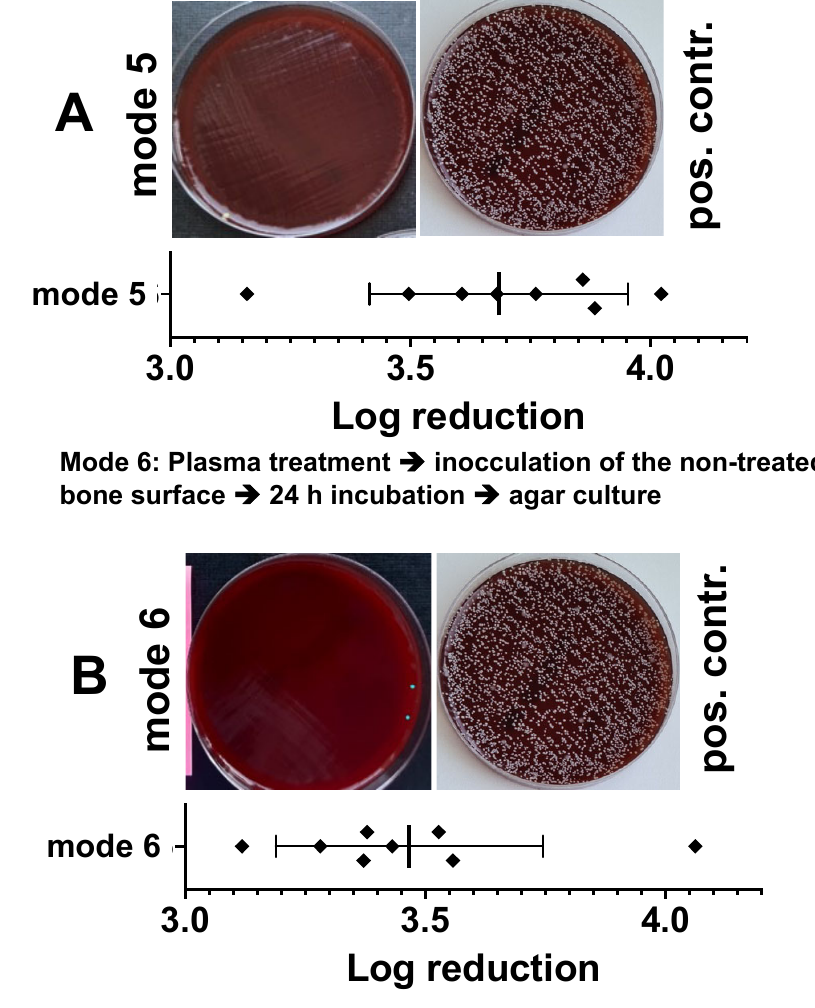
Figure 8. Characterization of the antibacterial effect of a preventive DBD CAP treatment in a model of a bacterially infected bone samples. Punch preparations from the pork shoulder blade were exposed to the DBD plasma (10 min at 275 mW power dissipation in the discharge). Ten minutes after plasma exposure, the non-treated side of the sample ( A , mode 5) or the plasma exposed bone area of the samples ( B , mode 6) were inoculated with the Staphylococcus epidermidis strain (1.5 × 10 6 ). After 24 h, the bacteria were detached from the bone preparations and the resulting bacterial solutions of mode 5 or mode 6 were spread out on agar plates (photographic images of A; mode 5 or B; mode 6). As a positive control (pos. contr.), the corresponding bone samples were treated identically, but not exposed to plasma. The quantitative evaluation was carried out by counting the photographically recorded colonies on the agar plate using the imageJ software. Bars shown represent the mean ± S.D. of six individual experiments. *, p < 0.05 as compared to the positive control (pos. contr.).